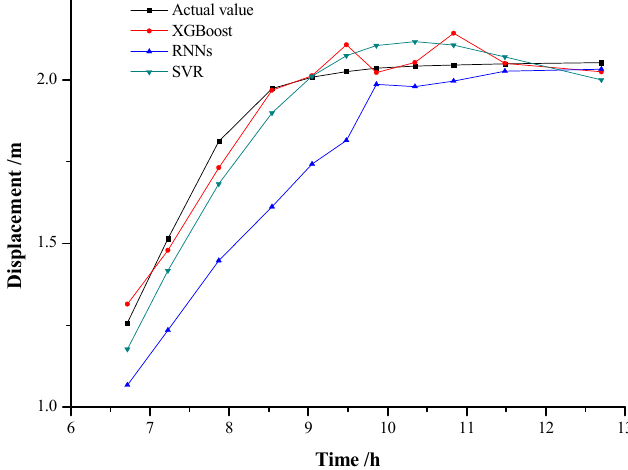
Figure 11. Variation of displacement predicted values of D10 with time.